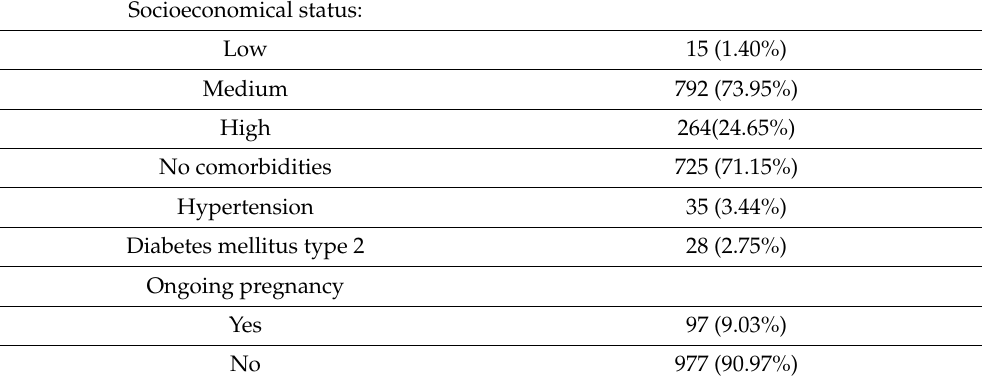
Table 1. Cont. Socioeconomical